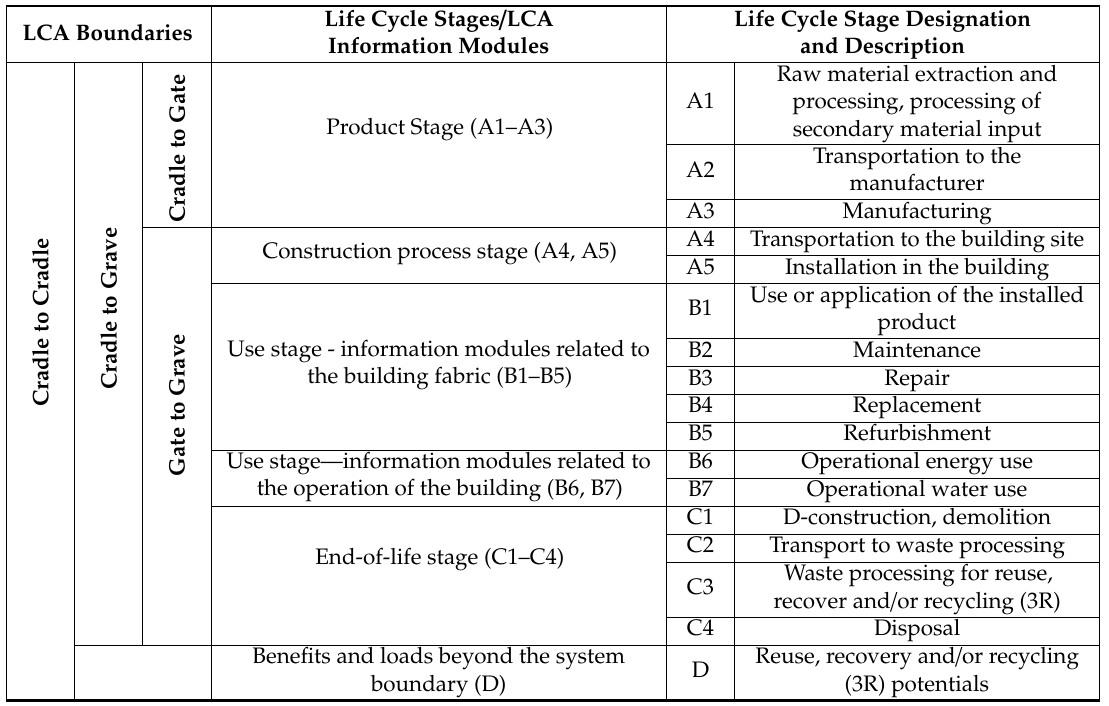
Table 3. Detailed life cycle stages of building materials classification